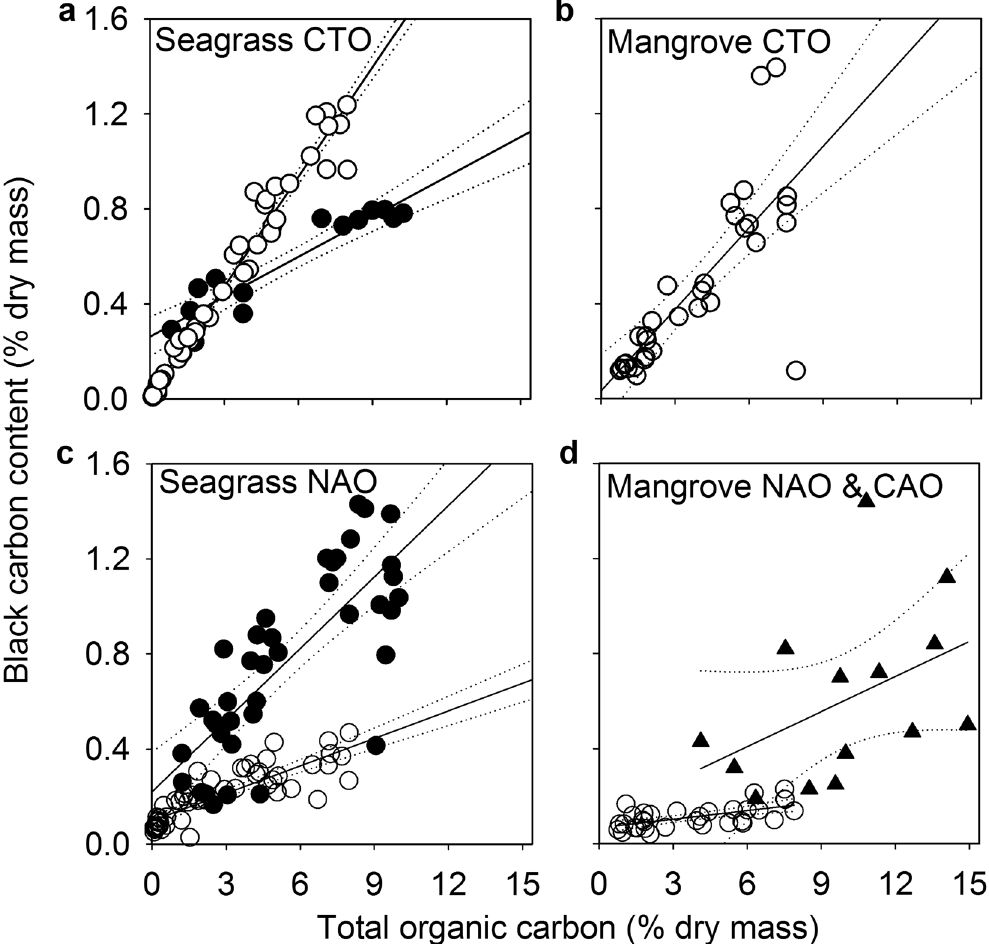
Figure 3. Ordinary least squares regressions for total organic carbon content against black carbon across seagrass and mangrove sediments. With the exception of Little Swanport estuary seagrass sediments, the regressions are constructed from measurements of black carbon (BC) as isolated via chemothermal oxidation (CTO), concentrated nitric acid oxidation (NAO), and dilute chromic acid oxidation (CAO) down seagrass and mangrove sediment cores along a sand-to-mud gradient of ( ○ ) the tropical lagoon Salut–Mengkabong, ( ● ) the temperate estuary Little Swanport, and ( ▲ ) the surface sediments of the subtropical Shantou wetlands. For Little Swanport seagrass sediments, the amount of BC isolated via NAO was calculated from regressions of loss on ignition of TOC vs total organic matter, and black organic matter vs BC, constructed across the seagrass and mangrove sediments of Salut–Mengkabong (Supplementary Figures S3 and S4). The regressions represent the sum of a proportional increase in BC associated with soil carbon washout and BC supply to the sediment from aeolian transport, as measured by the intercept. The difference between the mangrove regressions (ANCOVA) from Salut–Mengkabong and the Shantou wetlands ( d ) were not statistically different ( P = 0.15 of being the same). There was no evidence of serial correlation between the residuals; and so, the 95% confidence estimators (dotted lines) may be considered reasonable (see Supplementary Table S1 for regression equations and estimator